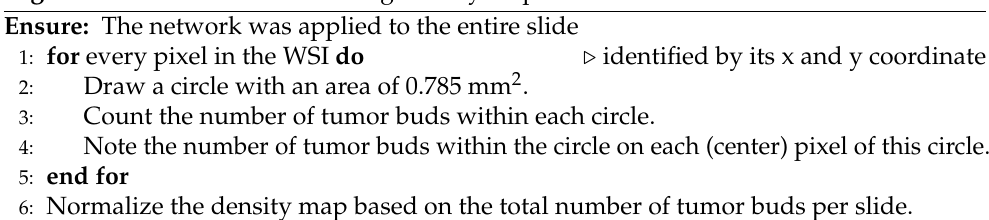
Algorithm 1 Create tumor budding density